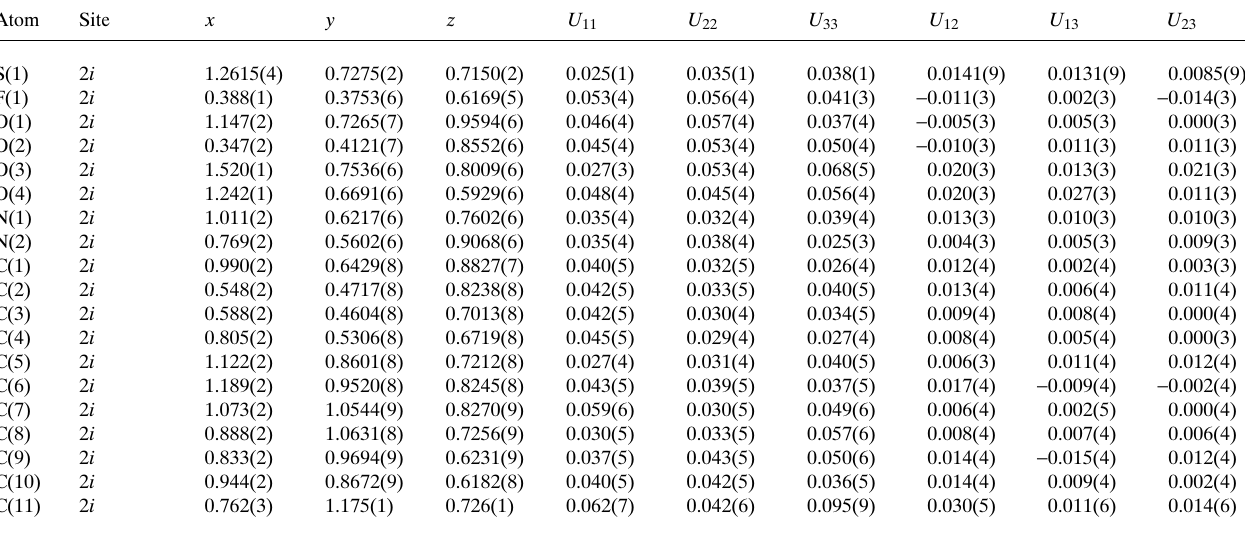
Table 3. Atomic coordinates and displacement parameters (in Å 2 )